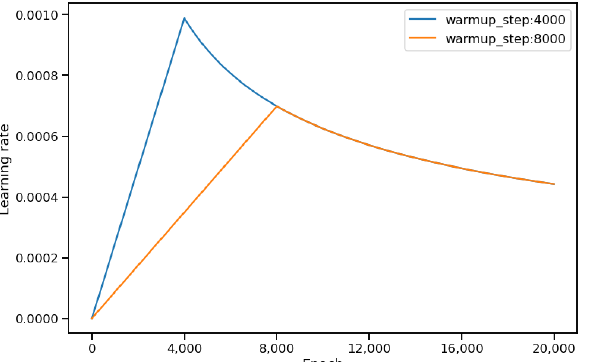
Figure 14. Warmup (learning rate initially set to 0, with warmup step at 4000 for the blue line and 8000 for the